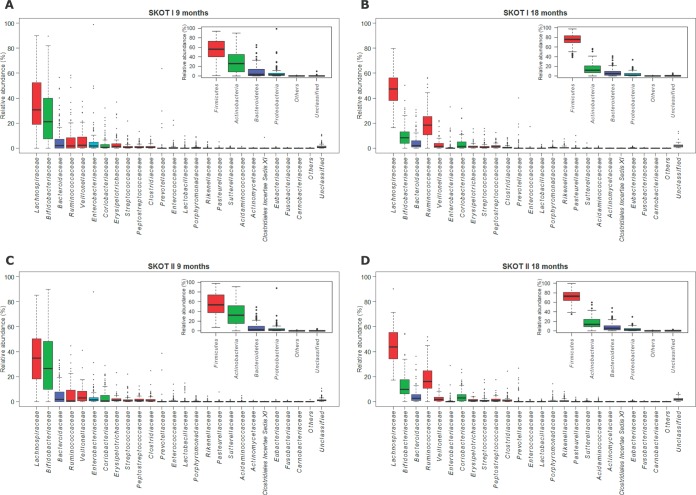
Composition of gut microbiota in SKOT I and SKOT II. Relative abundances of bacterial phyla (small panels) and families (large panels) in the SKOT I cohort (n = 114) at the ages of 9 months (A) and 18 months (B) and in the SKOT II cohort (n = 113) at the ages of 9 months (C) and 18 months (D). Boxes indicate 25th to 75th percentiles, with mean relative abundances marked as lines and whiskers indicating the range (minimum/maximum) multiplied by the interquartile range (25th to 75th percentiles) from the boxes. Bacterial families are ranked by average relative abundances at the age of 9 months. Detailed information can be found in Table S1 in the supplemental material.